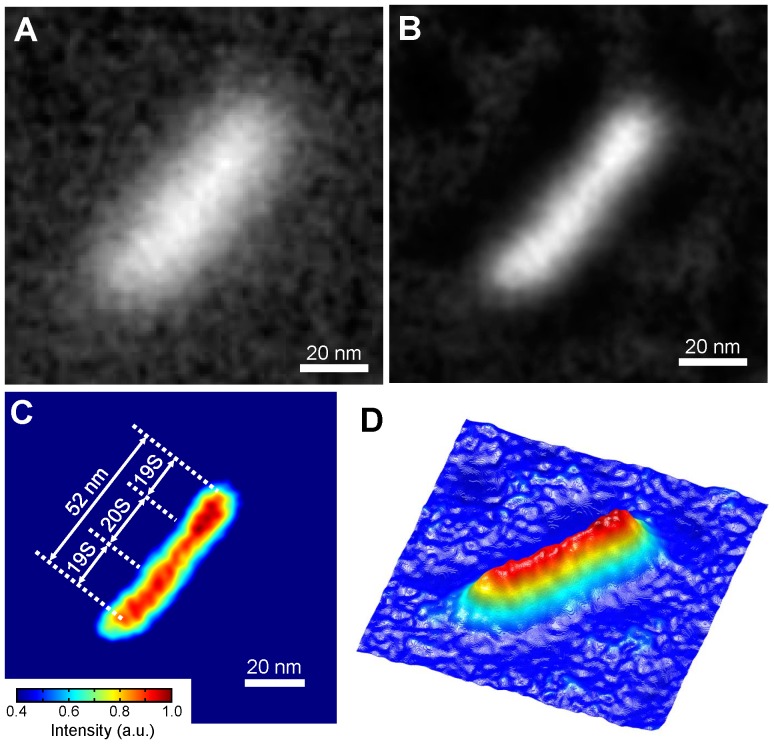
Observation of an unstained 26S proteasome.(A) Image of an unstained human erythrocyte 26S proteasome obtained by our method using FE-SEM. The image conditions are as follows: accelerating voltage 3.6-kV EB, application of a 2D Gaussian filter (size 9×9 pixels, σ = 2). A blurred dumbbell-shaped structure is visible. (B) Deconvolution proteasome image calculated using the Lucy–Richardson deconvolution algorithm. The dumbbell-shaped structure is more clearly defined. (C) Pseudo-colour map of a proteasome molecule of (B). (D) 3D colour map of the same 26S proteasome molecule. Two 19S cups and 20S core are defined. All scale bars: 20 nm.